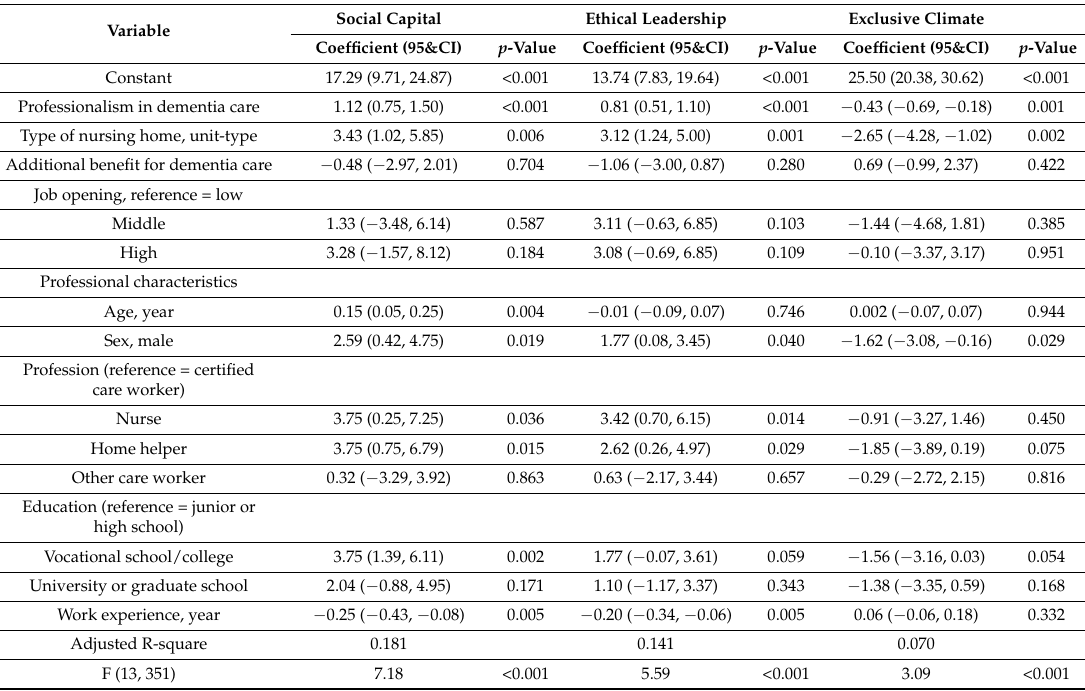
Table 2. Linear regression analysis of psychosocial work environment in 365 professional caregivers of special nursing